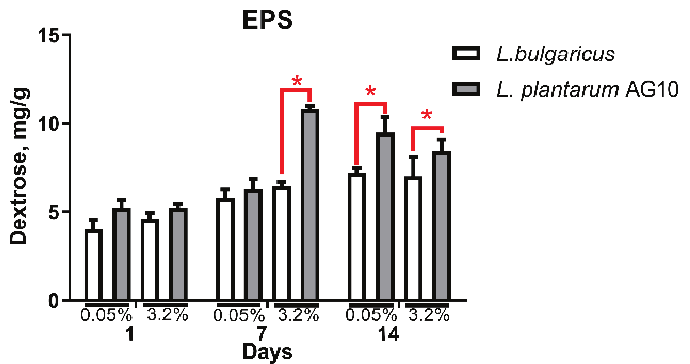
Figure 1. The amount of EPS in skimmed and whole milk fermented with either L. bulgaricus (shown in white) or L. plantarum AG10 (shown in gray) as judged by dextrose measurement after 1, 7, and 14 days of storage. Asterisks indicate a significant difference at p < 0.05. The initial fat percentage in the milk is shown under the x -axis.